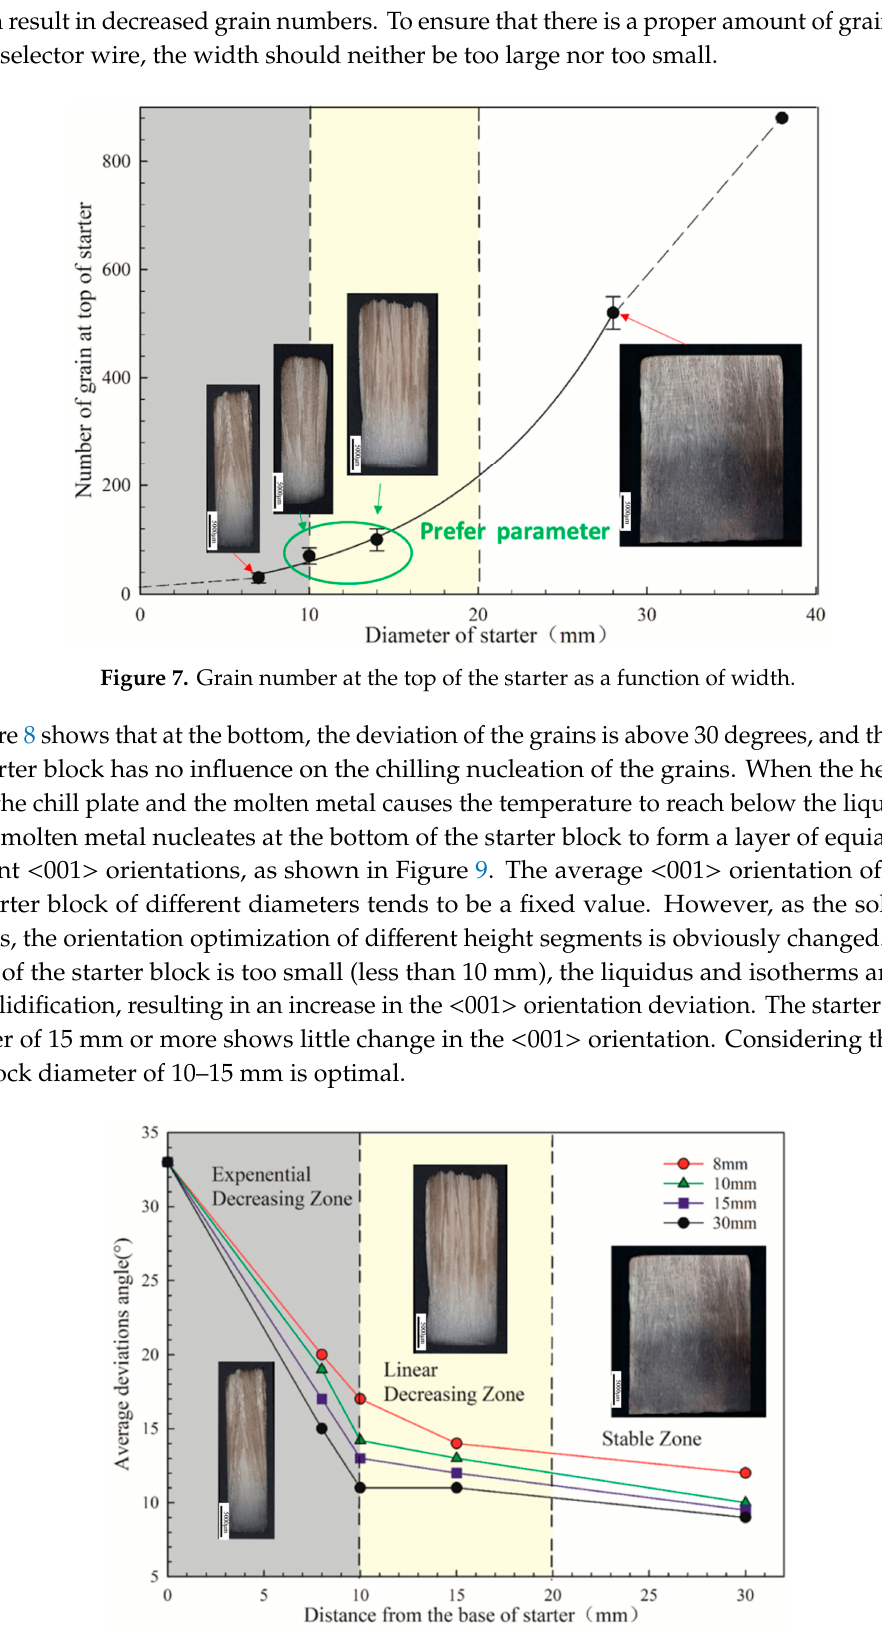
Figure 9. Schematic flow-process diagram of single crystal (SX) turbine blade investment casting with optimized starter block parameters (D = 10 mm and H = 30 mm).